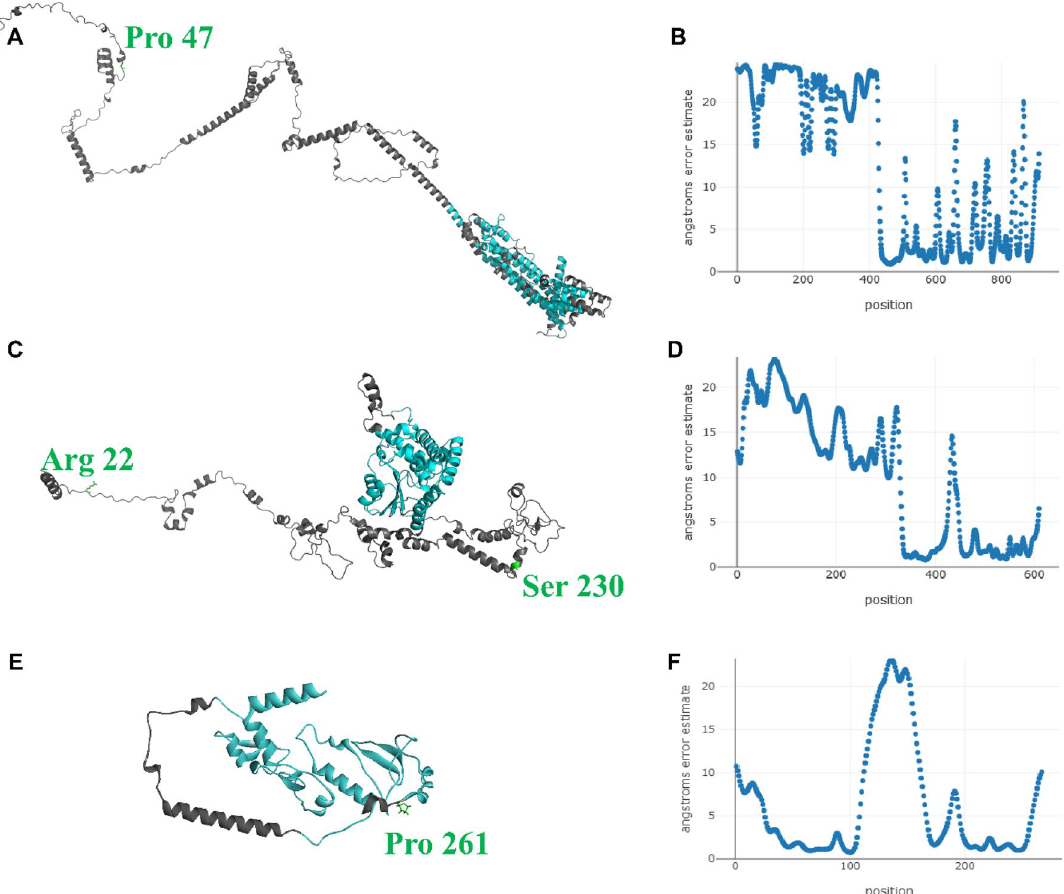
Figure 6. Structural models of turbot ( Scophthalmus maximus ) PAXBP1 ( A ), EYA3 ( C ) and IGFBP2 ( E ) as calculated by RoseTTAfold. Cartoon representation colored by local model quality: low-quality and high-quality in grey and light blue, respectively. The local quality of the three models, expressed in per-residue error estimate, is shown in panel ( B ) (PAXBP1), ( D ) (EYA3) and ( F )